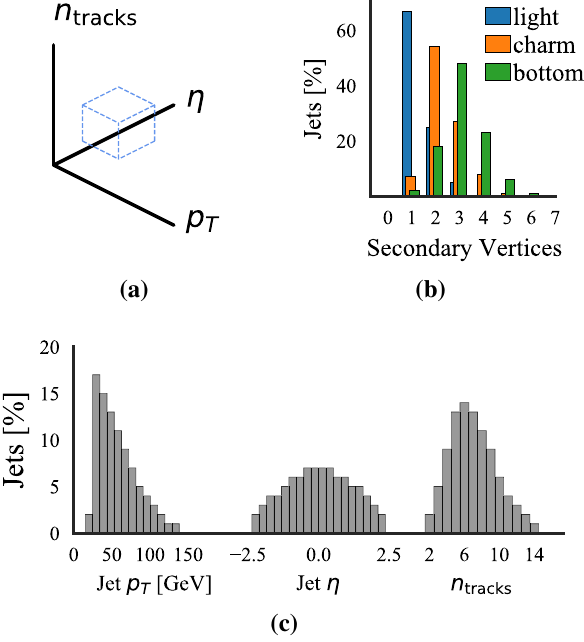
Fig. 2 a The dataset is composed by selecting equal numbers of jets from each flavor in each bin of p T , η , and n tracks . b Distribution of the numberofsecondaryverticesforthedifferentjetflavors. c Theresulting distribution of p T , η , and n tracks in the